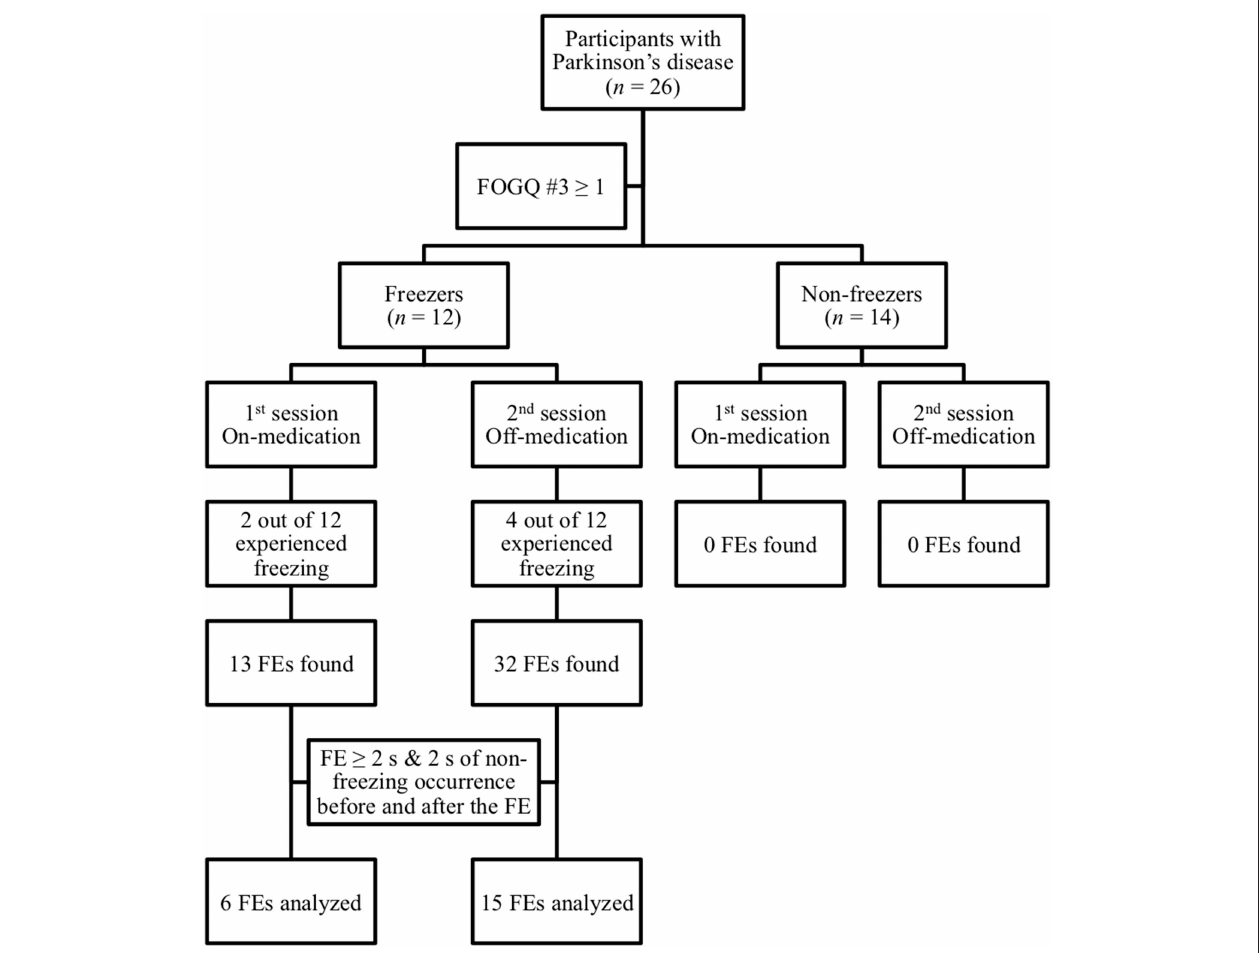
FIGURE 3 | Schematic flow chart showing participants’ categorization in freezers and non-freezers according to their self-reports scores of item 3 on the Freezing of Gait Questionnaire (FOGQ). Only the freezing episodes (FEs) lasting 2s or more and with at least 2s on non-freezing occurrence before and after (21 out of 45) were considered for